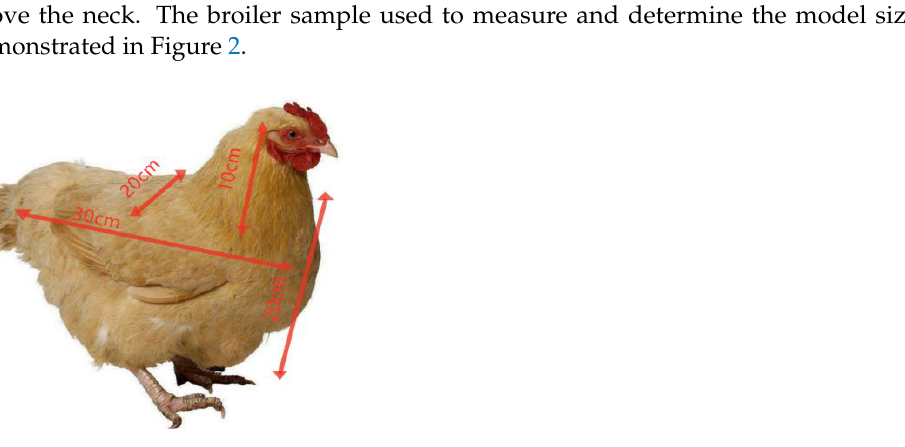
Figure 1. Measurements of broiler size: ( a ) measure the height of an adult broiler, ( b ) measure the length of an adult broiler.